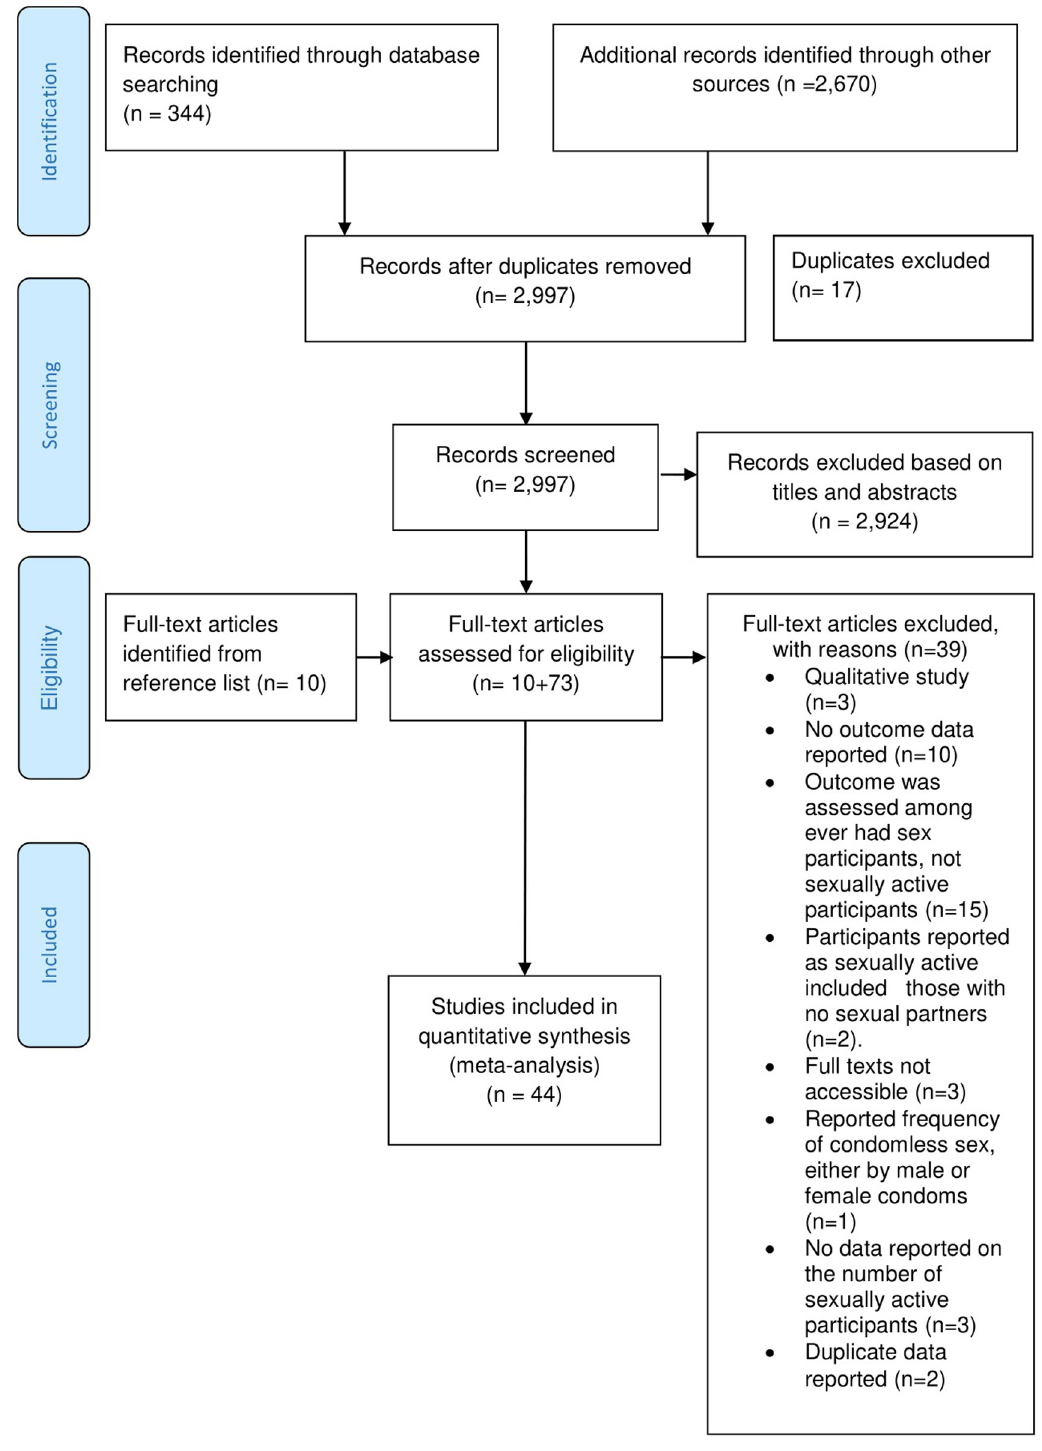
Fig 1. A PRISMA flow chart showing the identification, screening, and selection of primary studies.